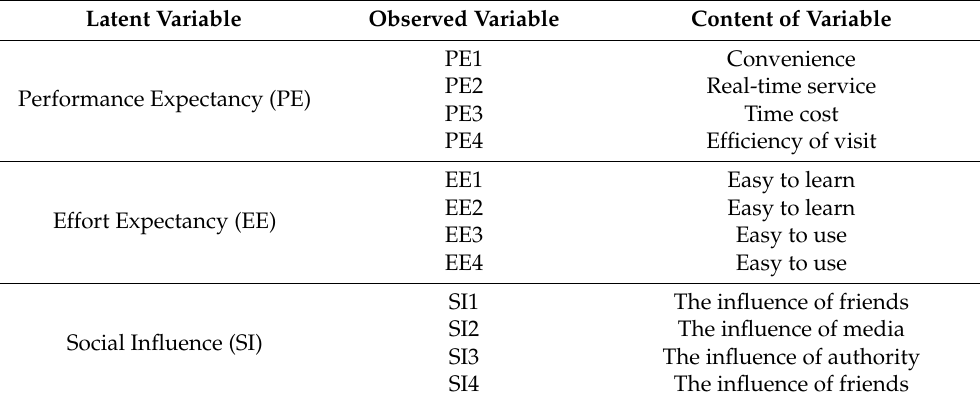
Table 4. Definition of latent and observed